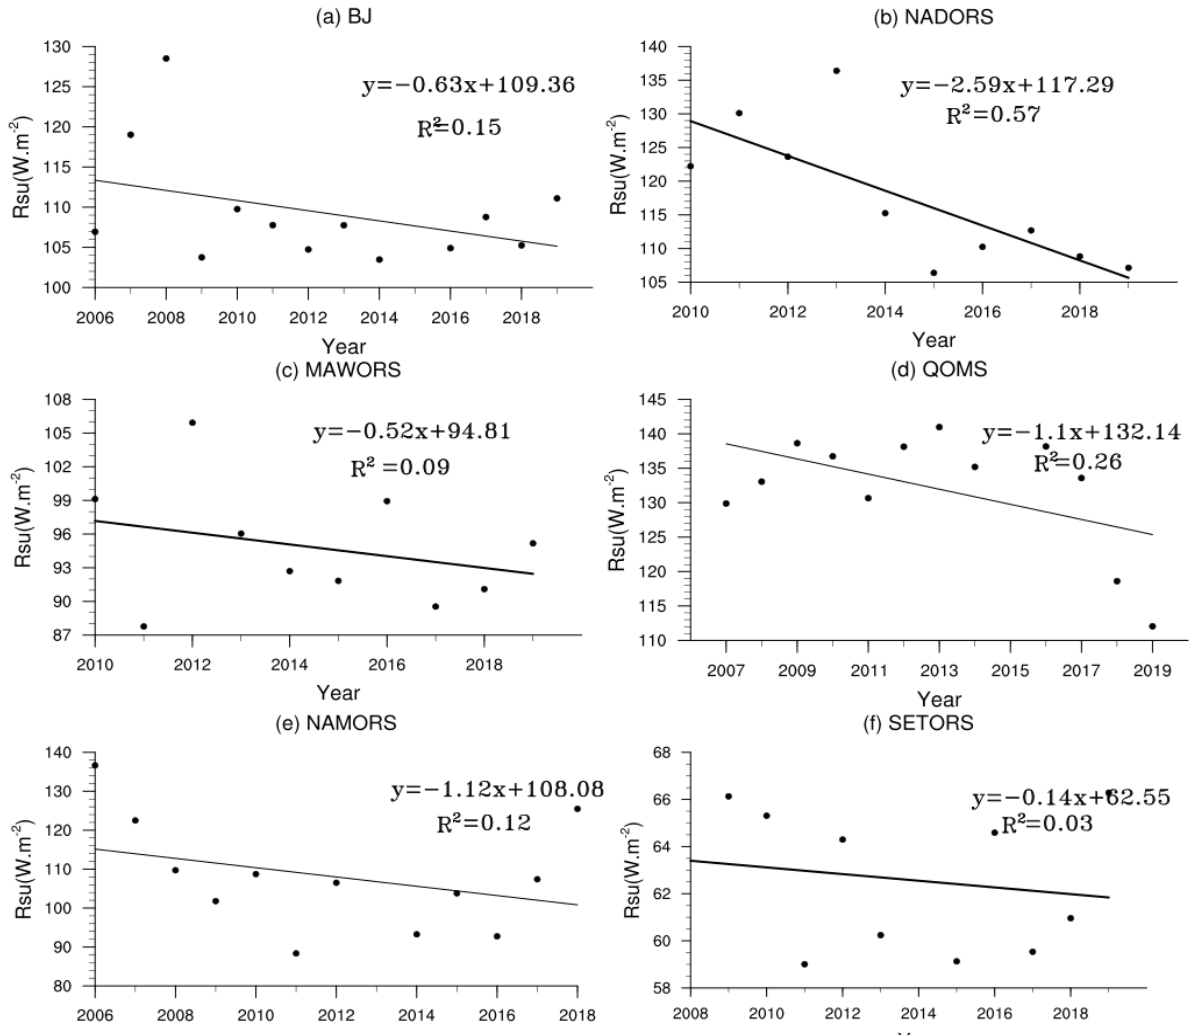
Figure 9. Interannual variation of upward shortwave radiation at each station.